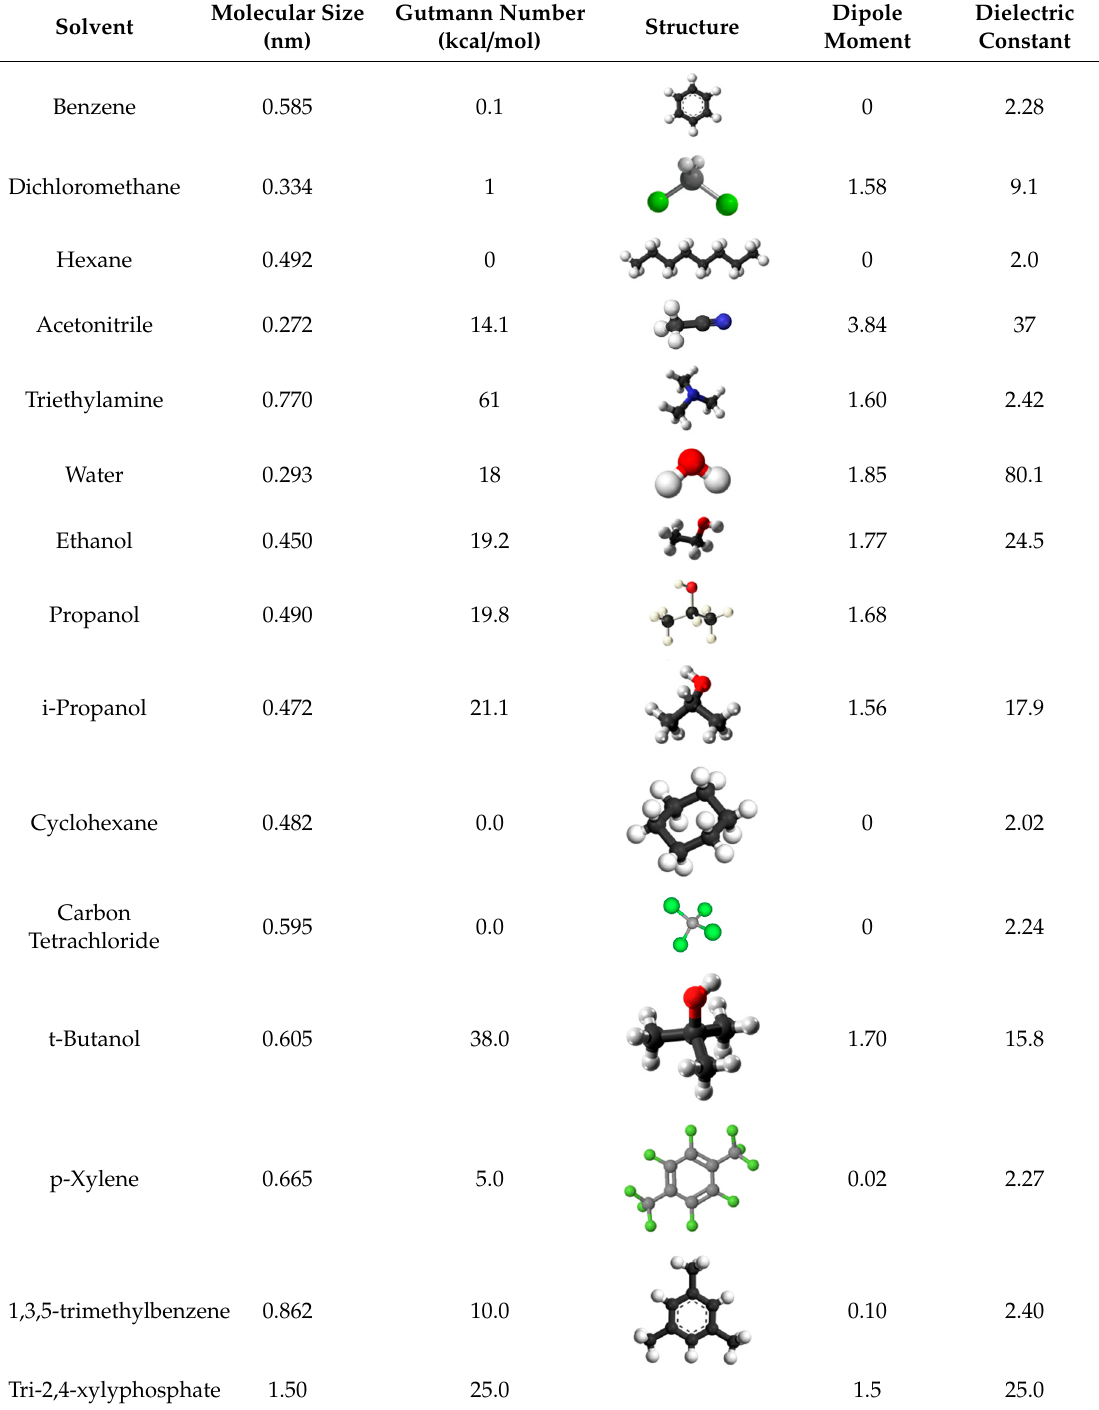
Table 5. Characteristics of the probe molecules used in the calorimetric study.